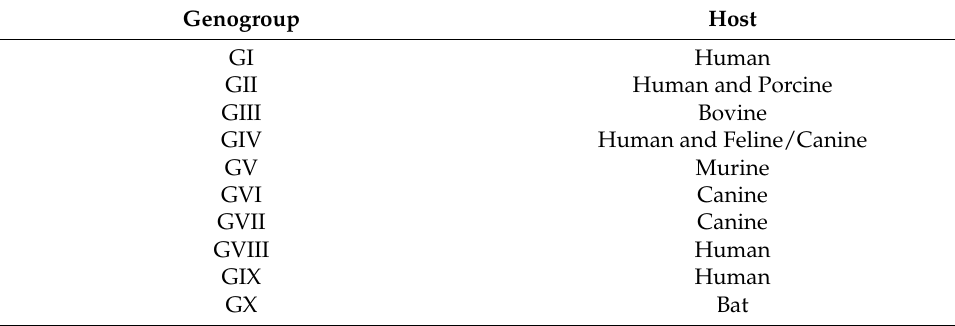
Table 2. NoV Genogroups and Hosts [13,79,80]. Genogroup Host